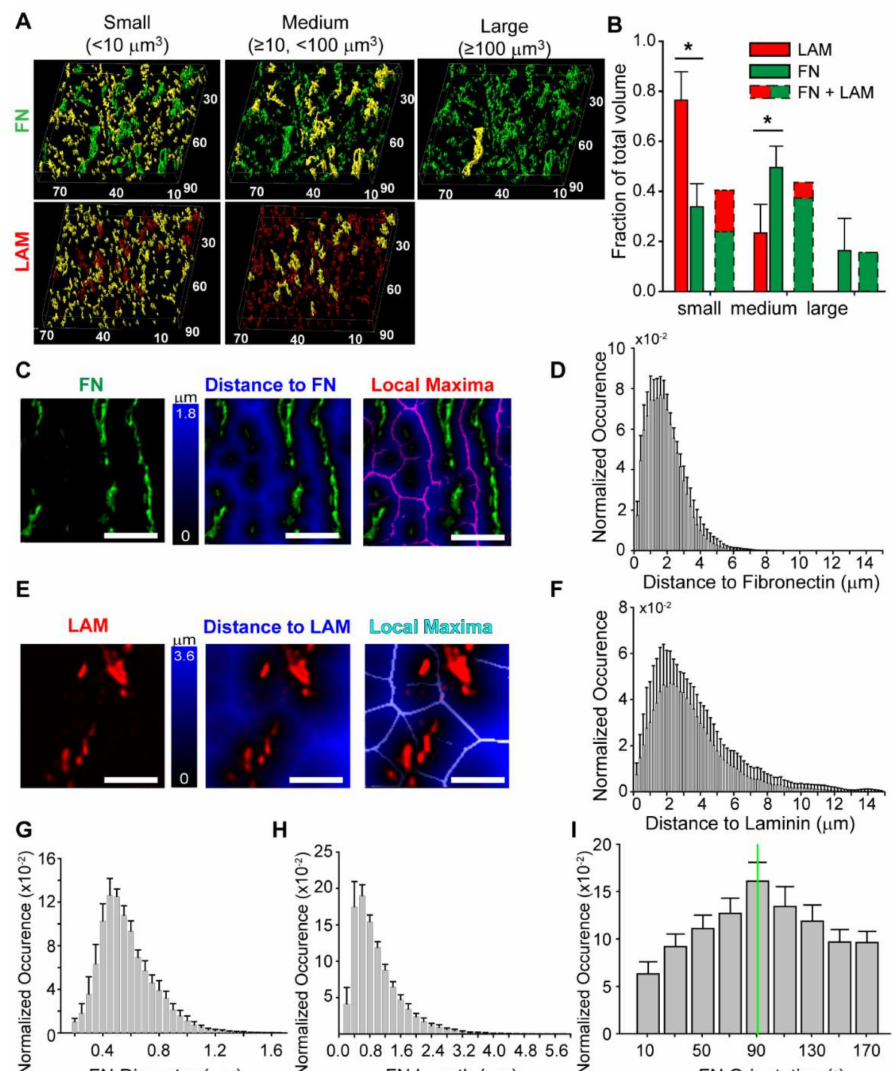
Figure 5. Quantitative analysis of fibronectin and laminin in the myocardium at 5 days.( A ) ECM structures segmented using Imaris into “surfaces” were sorted into small, medium, or large groups depending on their volume. The ECM structures in each group are highlighted in yellow in 3D representations of fibronectin (green) and laminin (red). Scale is in micrometers. ( B ) Volume distribution of fibronectin and laminin, the dashed bars indicate the relative volume of each component (*, p < 0.01 determined by t -test). ( C ) The fibronectin image (green) was processed to find the distance of all points in the image from the fibronectin “surface,” where the value of each voxel is equal to the closest distance of the voxel to a fibronectin “surface.” The local maxima is a 2D image with all points equidistant from fibronectin “surfaces” highlighted in purple. Scale bars are 4 µ m. ( D ) Histogram of distance to fibronectin showing mean ± standard deviation for each bin across all samples ( n =